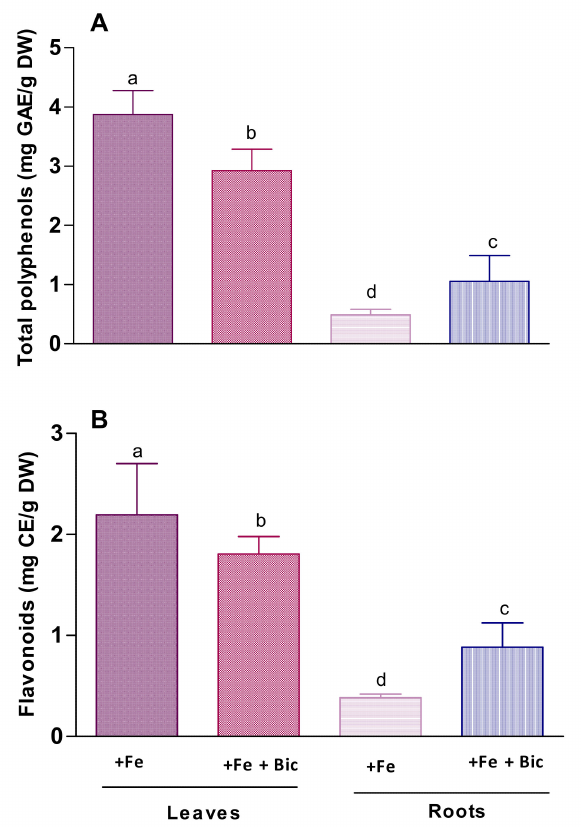
Figure 4. Levels of total phenolic compounds ( A ) and of flavonoids ( B ) in leaves and roots of fennel plants grown under Fe sufficiency (+Fe) or under Fe deficiency conditions (+Fe +Bic). Data represent the mean ± standard deviation of three independent assays. Values with different superscripts are significantly different at p <